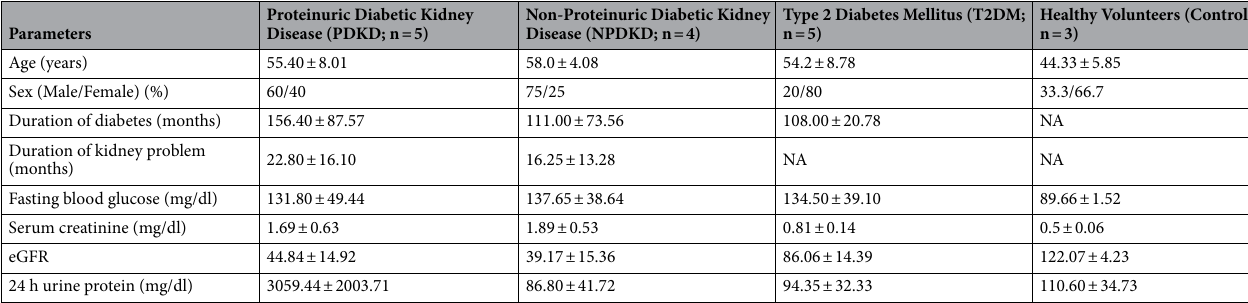
Table 2. Demographic and clinical parameters of the study groups. Data are shown as Mean ± Standard Deviation. NA, not applicable; mg/dl, milligrams/deciliter.